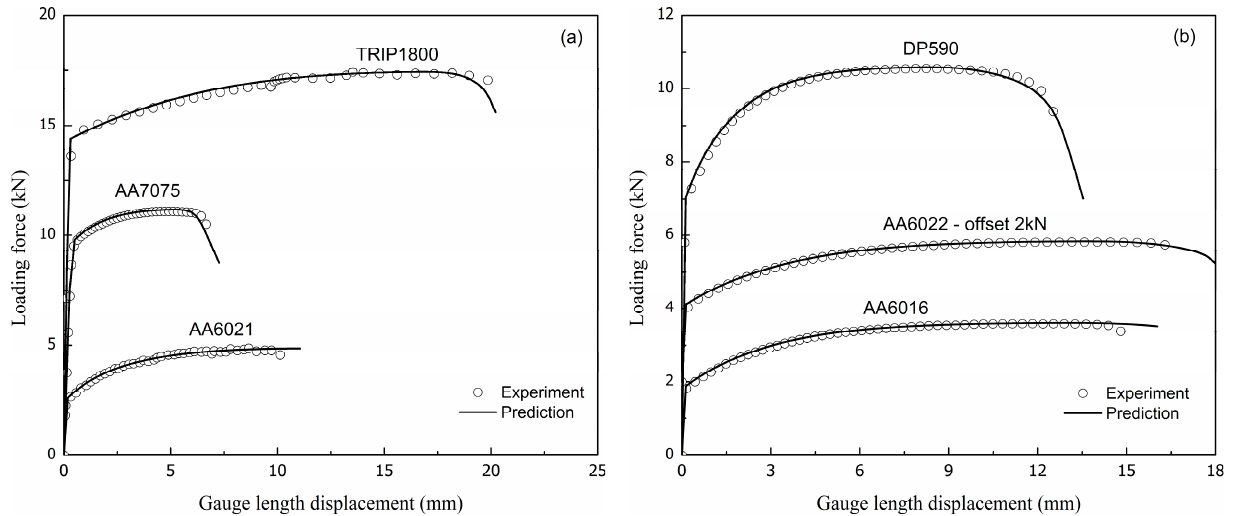
Figure 11. Tensile force predictions of ( a ) Proposed 1 and ( b ) Proposed 4 models for several mate- rials.